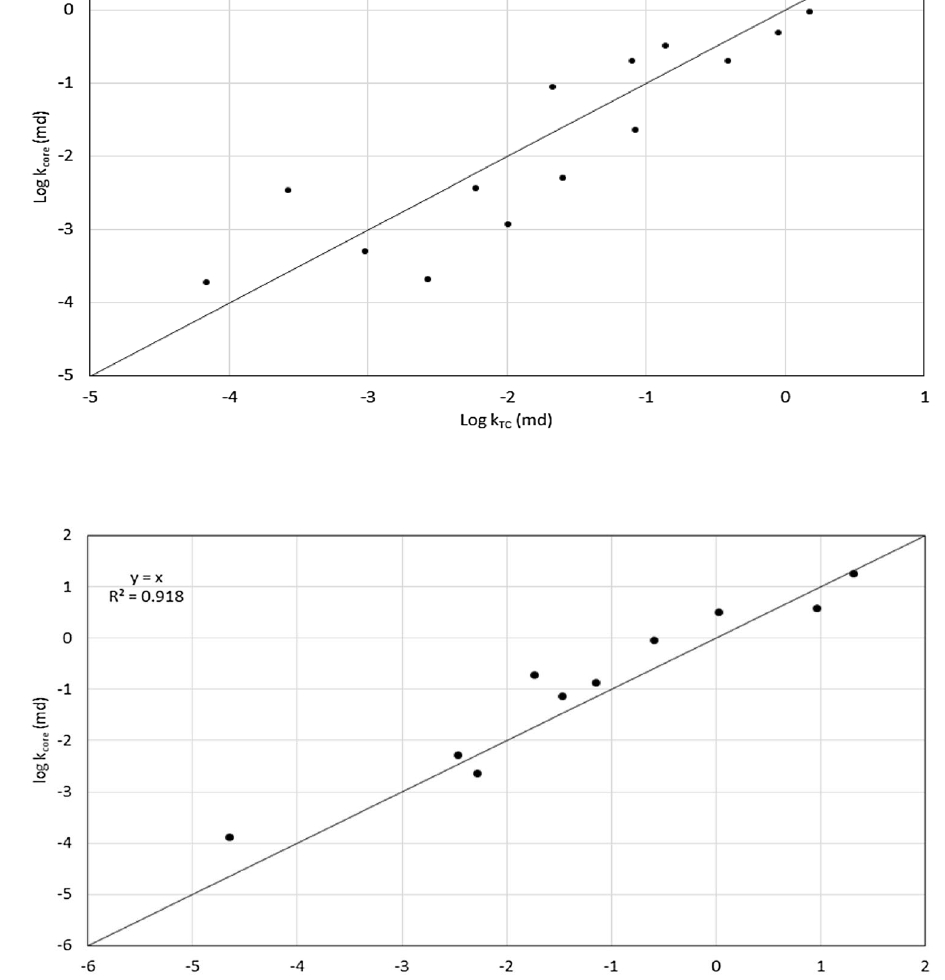
Fig. 11 Correlation of core permeability and permeability of modified TC model (design model, m = 3.91, n = 0.51)